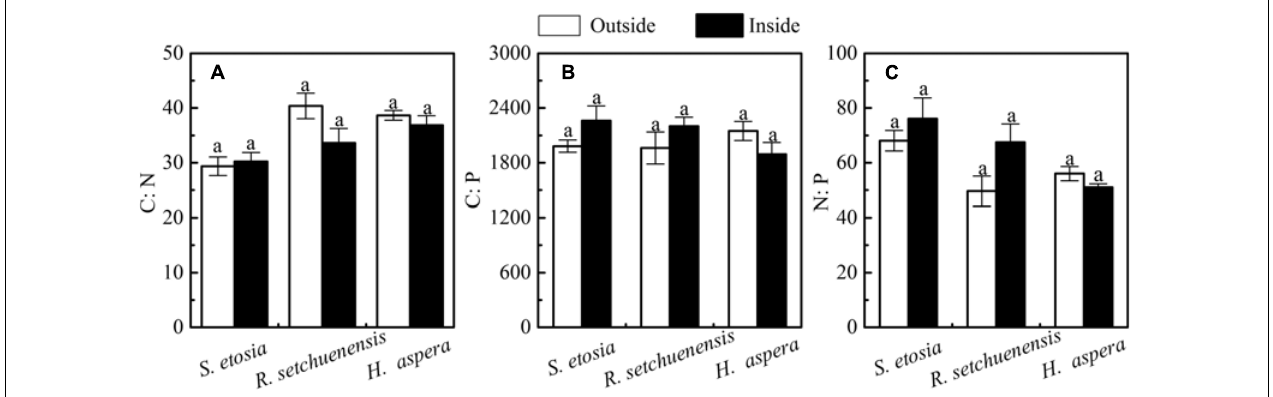
FIGURE 3 | Leaf C:N:P stoichiometry of the three shrubs outside and inside; sample numbers, N: 120 < N < 200. (A–C) refer stoichiometric ratios leaf carbon content/leaf nitrogen content, leaf carbon content/leaf phosphorus content, and leaf nitrogen content/leaf phosphorus content, respectively.